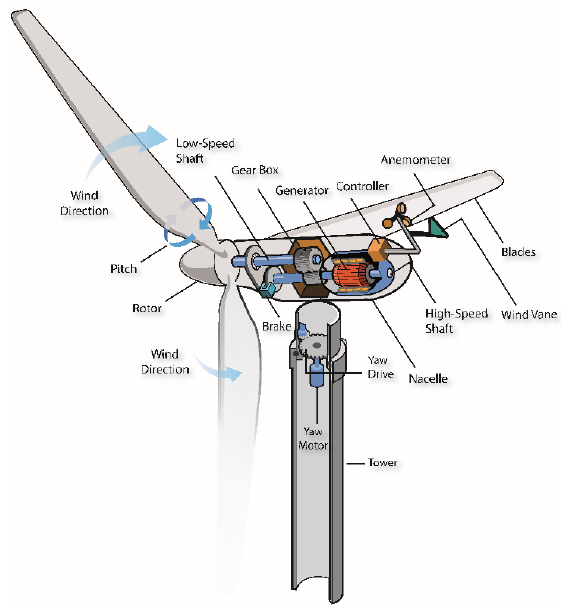
Figure 1. A schematic diagram of the wind turbine